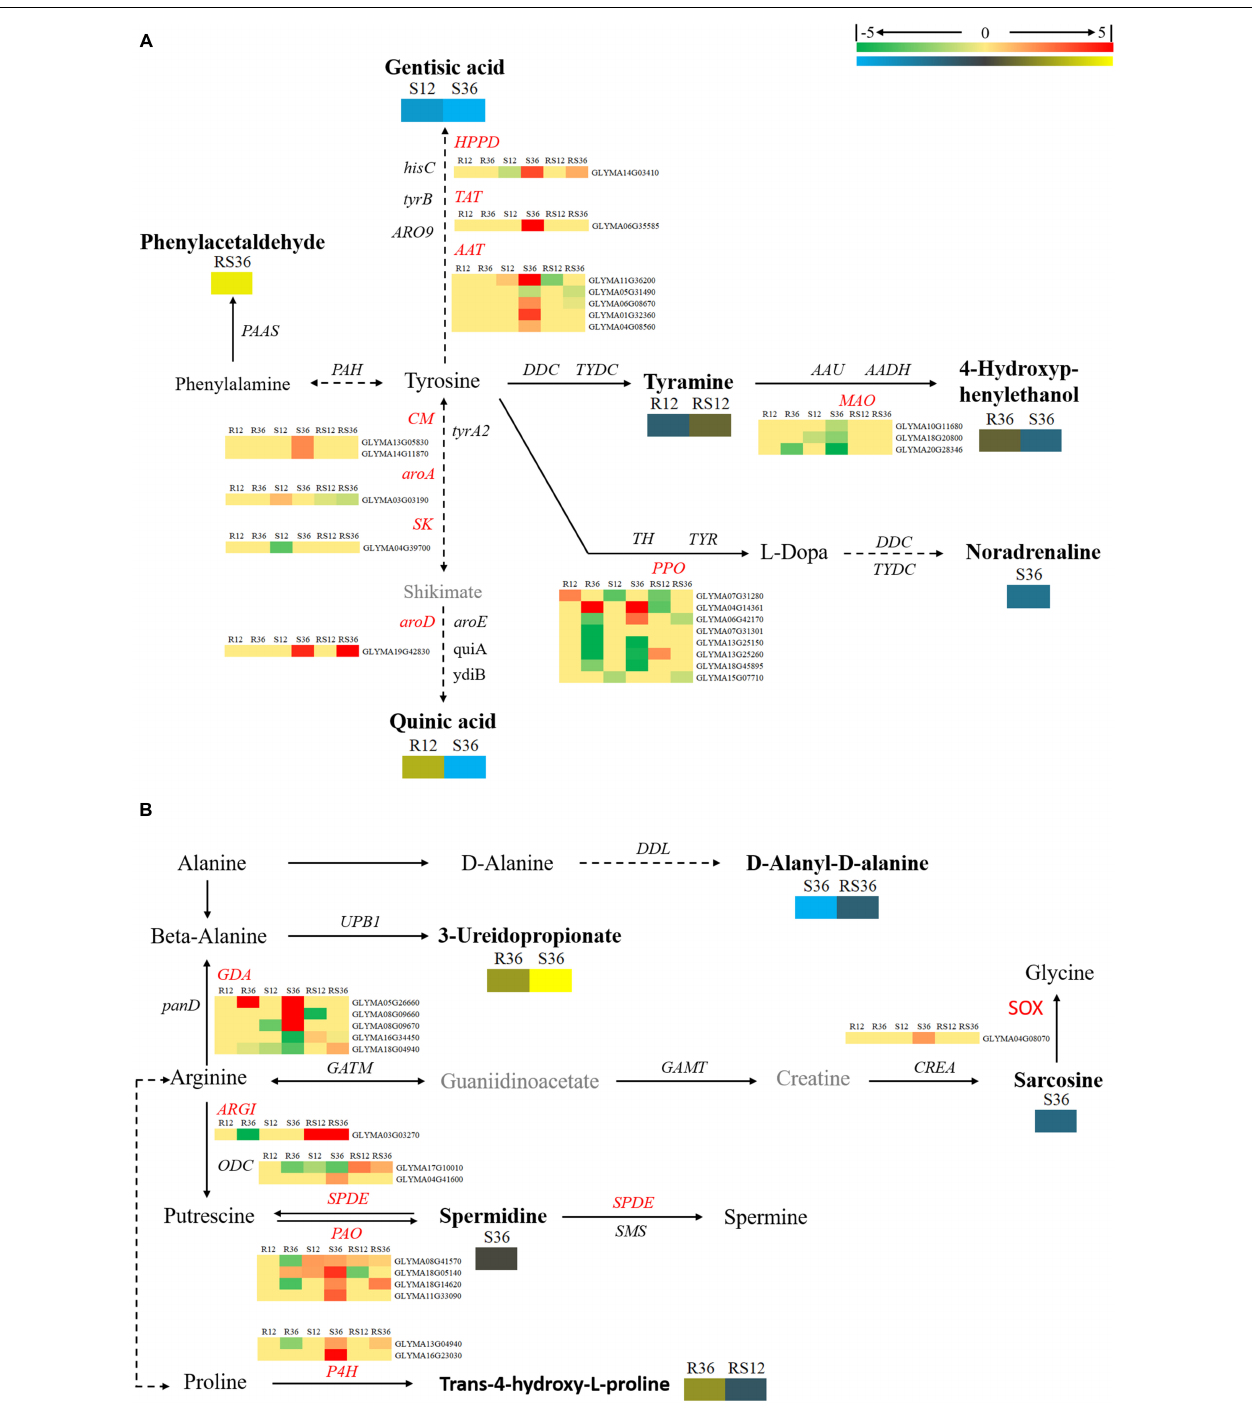
FIGURE 4 | Diagram of amino acid metabolism pathways with their related DEGs and DAMs. (A) Pathway of tyrosine and phenylalanine metabolism. (B) Pathways of beta-alanine, proline, and arginine metabolism. DAMs are in bold black fonts. No significantly differentially accumulated metabolites are in black fonts, unidentified metabolites are in gray fonts, and the abbreviations of gene names are in italics. The log 2 Foldchange was colored using Cluster 3.0 (red for upregulated DEGs, green for downregulated DEGs, yellow for upregulated DAMs, and blue for downregulated DAMs), and the vertical columns represent R12, R36, S12, S36, RS12 and RS36, from left to right. R12: R-12h-IN vs. R-12h-CK; R36: R-36h-IN vs. R-36h-CK; S12: S-12h-IN vs. S-12h-CK; S36: S-36h-IN vs. S-36h-CK; RS12: R-12h-CK vs. S-12h-CK; and RS36: R-36h-CK vs. S-36h-CK. IN, inoculated; CK, control check. A color bar is in the upper right corner. Abbreviations of gene names are listed in Supplementary Excel S4